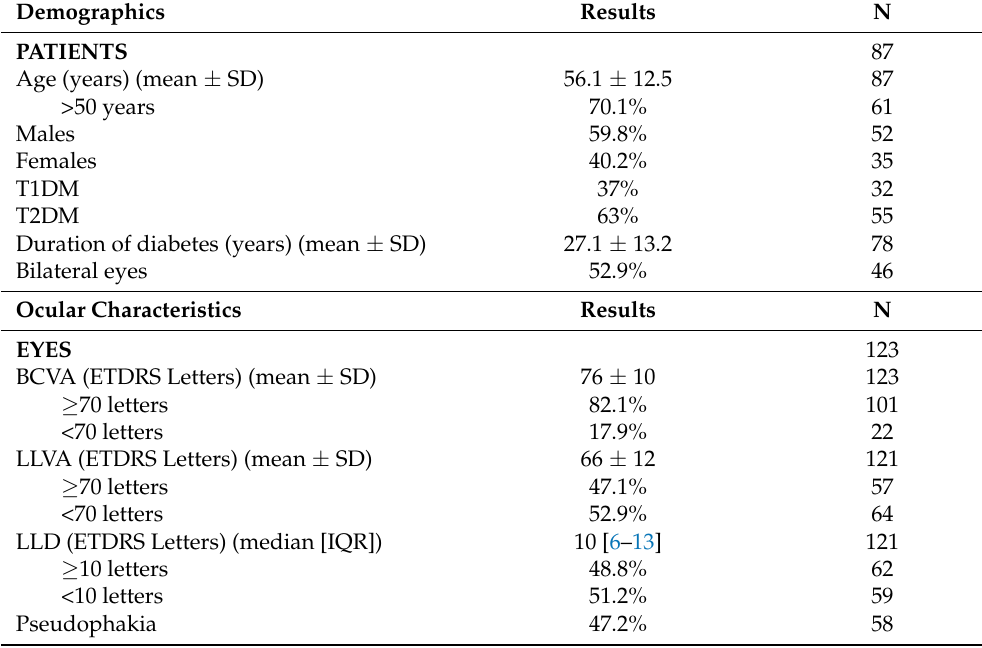
Table 1. Baseline systemic and ocular